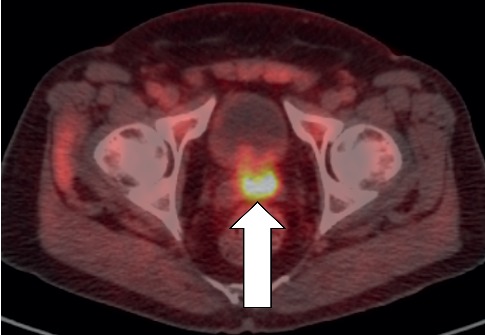
Image of a 72-year-old male who had undergone Calypso-guided intensity-modulated radiotherapy and cyberknife treatment of a right-sided iliac lymph node (identified on a prior 18F-fluciclovine study). He was referred for 18F-fluciclovine imaging with PSA rising to 15.1 ng/mL. This axial, fused PET/CT image shows intense 18F-fluciclovine uptake in the left side of the prostate gland (white arrow), consistent with prostate cancer recurrence.